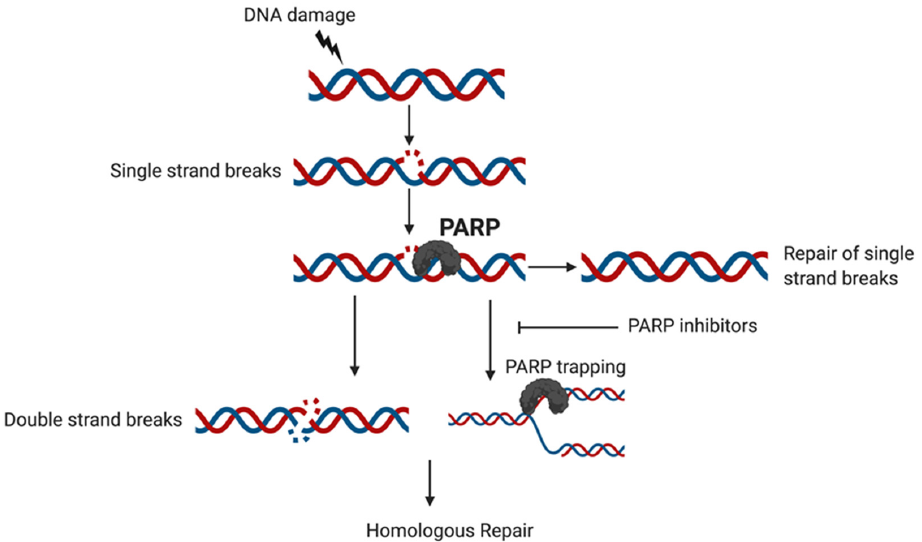
Figure 1. DNA damage may lead to single strand breaks; PARP detects the DNA lesion in the single strand break. PARP takes part in recruiting repair factors to the single stranded DNA lesion site and promotes the activity of enzymes during the repair. PARP inhibitors function by reducing the catalytic activity of PARPs and can help prevent single strand break repair which can lead to double strand breaks which can’t be repaired by BRCA mutant tumors or can trap PARP at the site of DNA damage via preventing PARP detachment from DNA. This then prevents the replication fork from progressing and leads to cell death unless this damage is repaired.